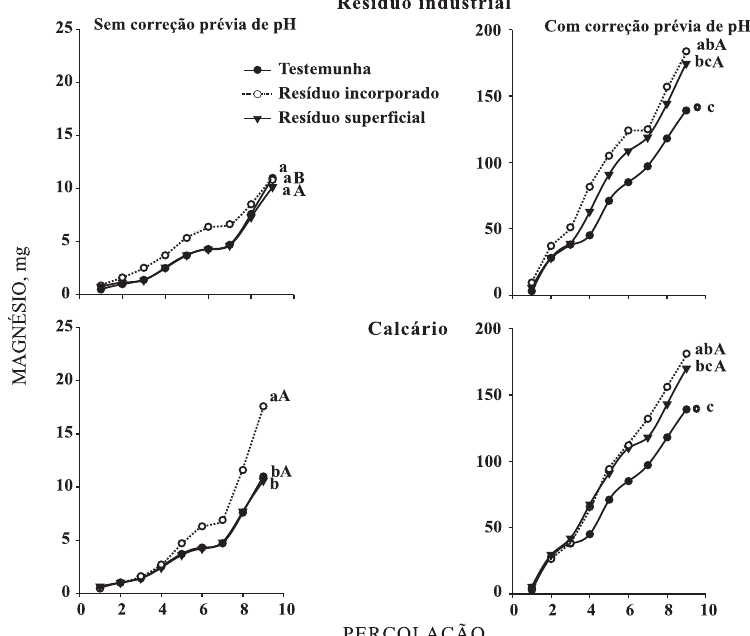
Figura 4. Perdas acumuladas de magnésio após 10 percolações de água destilada em conseqüência da aplicação de calcário ou de um resíduo industrial em amostras de solo com e sem correção prévia de pH. (Letras minúsculas comparam as formas de aplicação de cada corretivo com a testemunha dentro de cada pH; letras maiúsculas comparam esses mesmos tratamentos entre os corretivos da acidez, dentro do mesmo pH. Ausência de letra significa inexistência de diferença estatística pela análise de contraste a 5